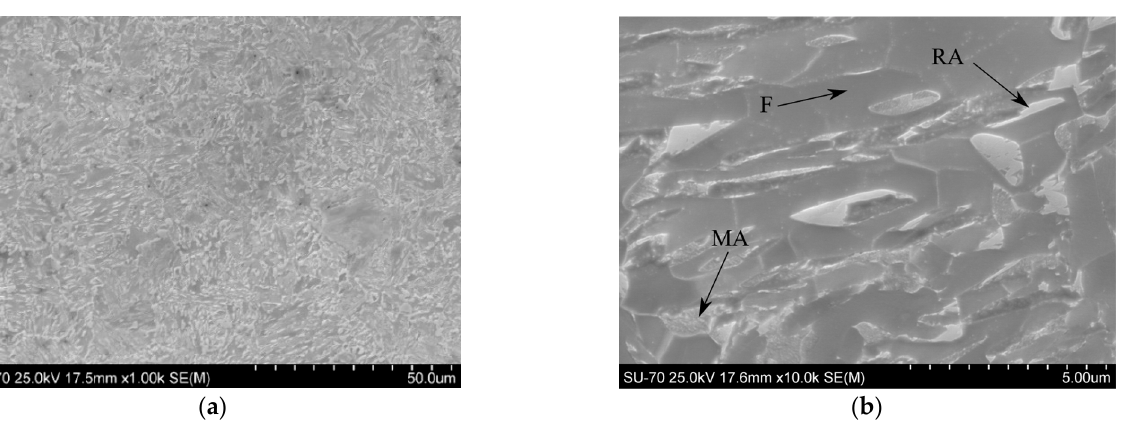
10%), which, in turn, is stabilized by the carbon enrichment during the partitioning step [11].